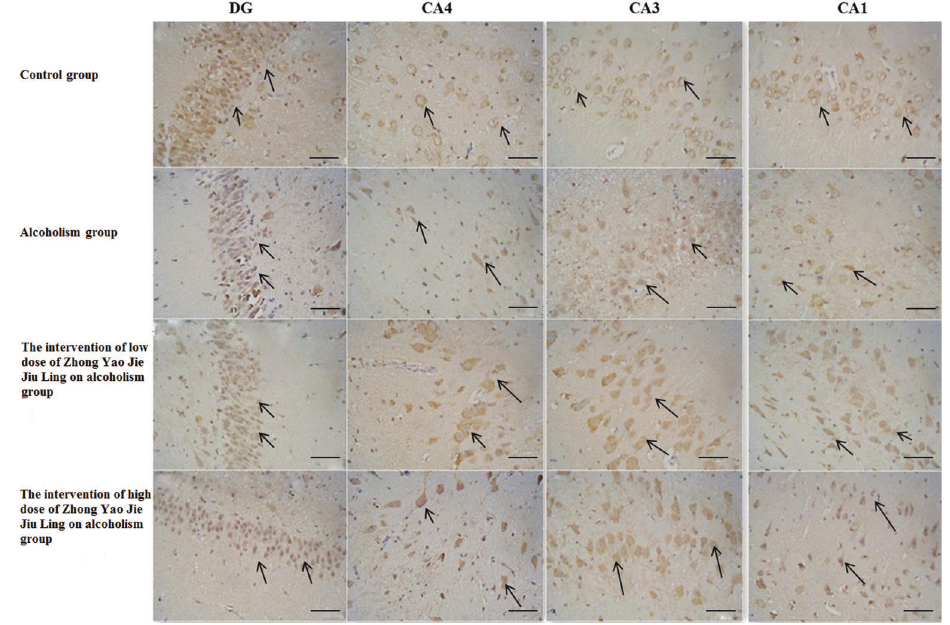
Figure 2. Brain-derived neurotrophic factor (BDNF)-positive neurons in the dentate gyrus (DG) and hippocampus (CA4, CA3, and CA1) in the four groups (bars: 100 m m). The arrows indicate BDNF-positive